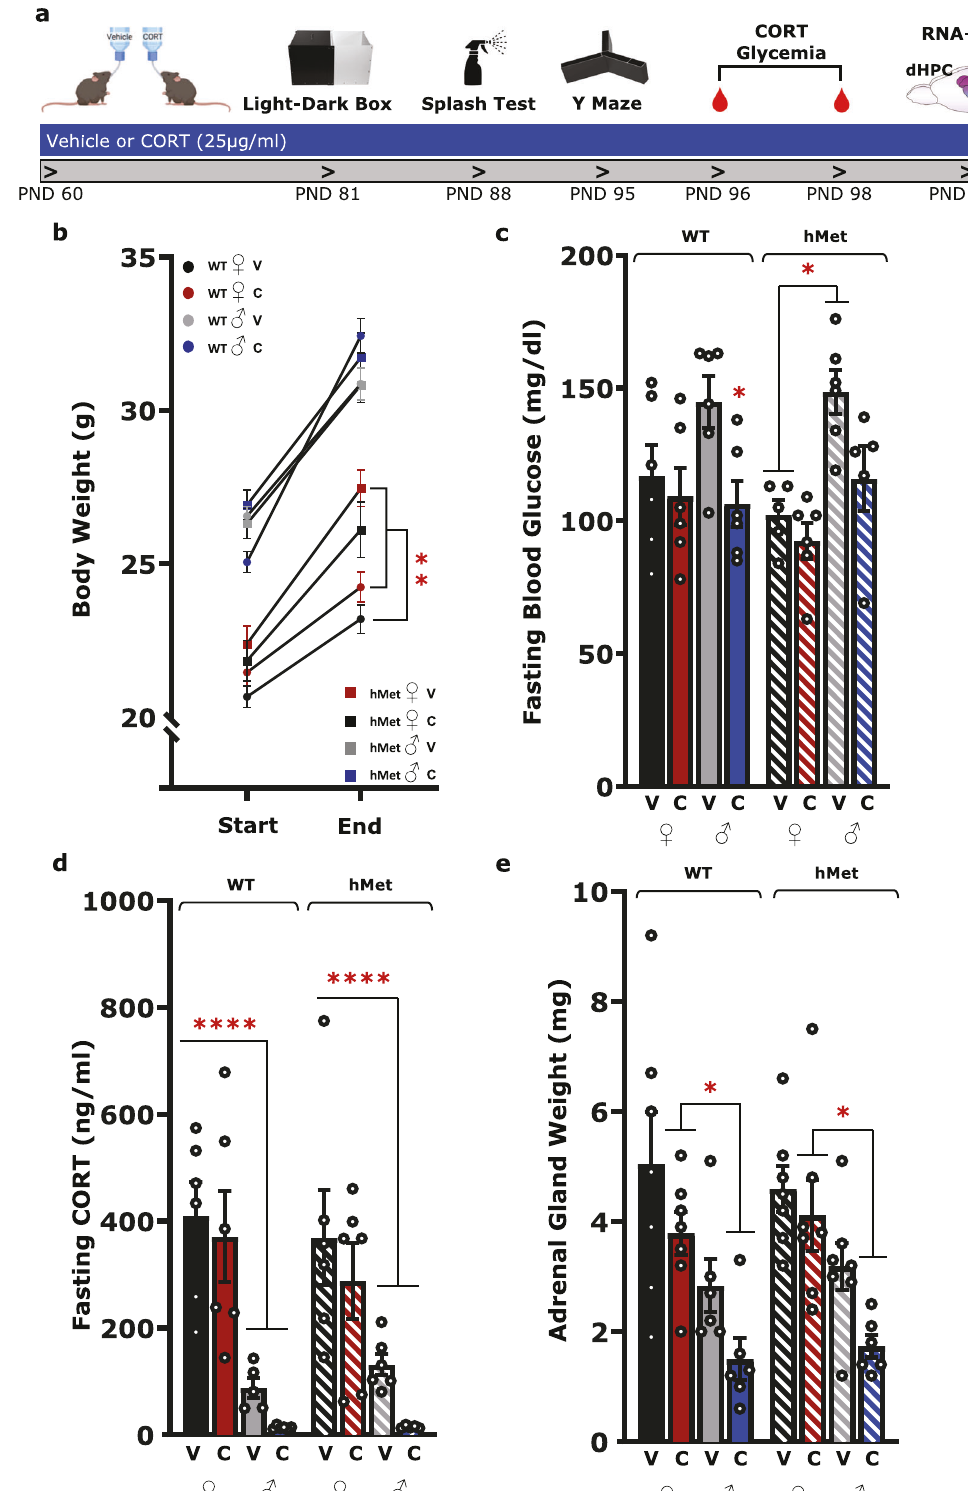
Using RNA-sequencing, RT-qPCR, and Methylated DNA Immu- nopreciptation (MeDIP) we investigated the epigenetic signatures in the dHPC and vHPC induced by chronic low doses of oral CORT as a function of sex and genotype. We report behavioral sex differences in response to CORT, as well as sex- and genotype- speci fi c genomic effects in the dHPC and vHPC that included